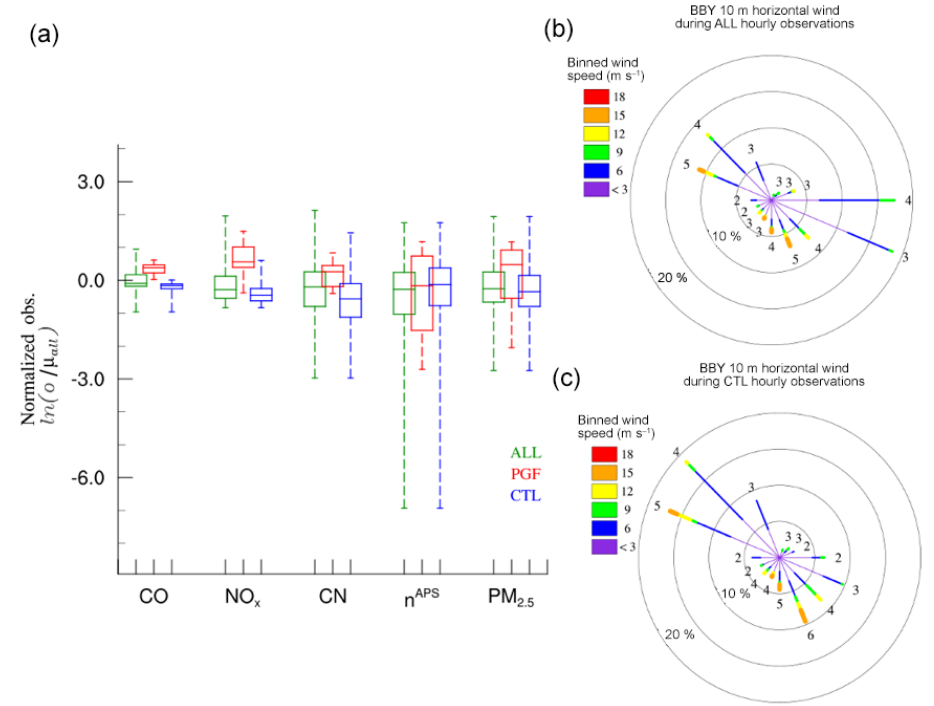
Figure 3. (a) Box-and-whisker plot displaying normalized peripheral measurements during all (ALL – green) hourly CalWater 2015 periods, PGF (PGF – red) periods, and CTL (CTL – blue) periods. (b) BBY 10m wind rose diagram for ALL. Rings represent probability of wind from displayed direction; petals represent relative distribution of wind speeds (color bar – ms − 1 ) from the given direction. (c) As in (b) but for CTL